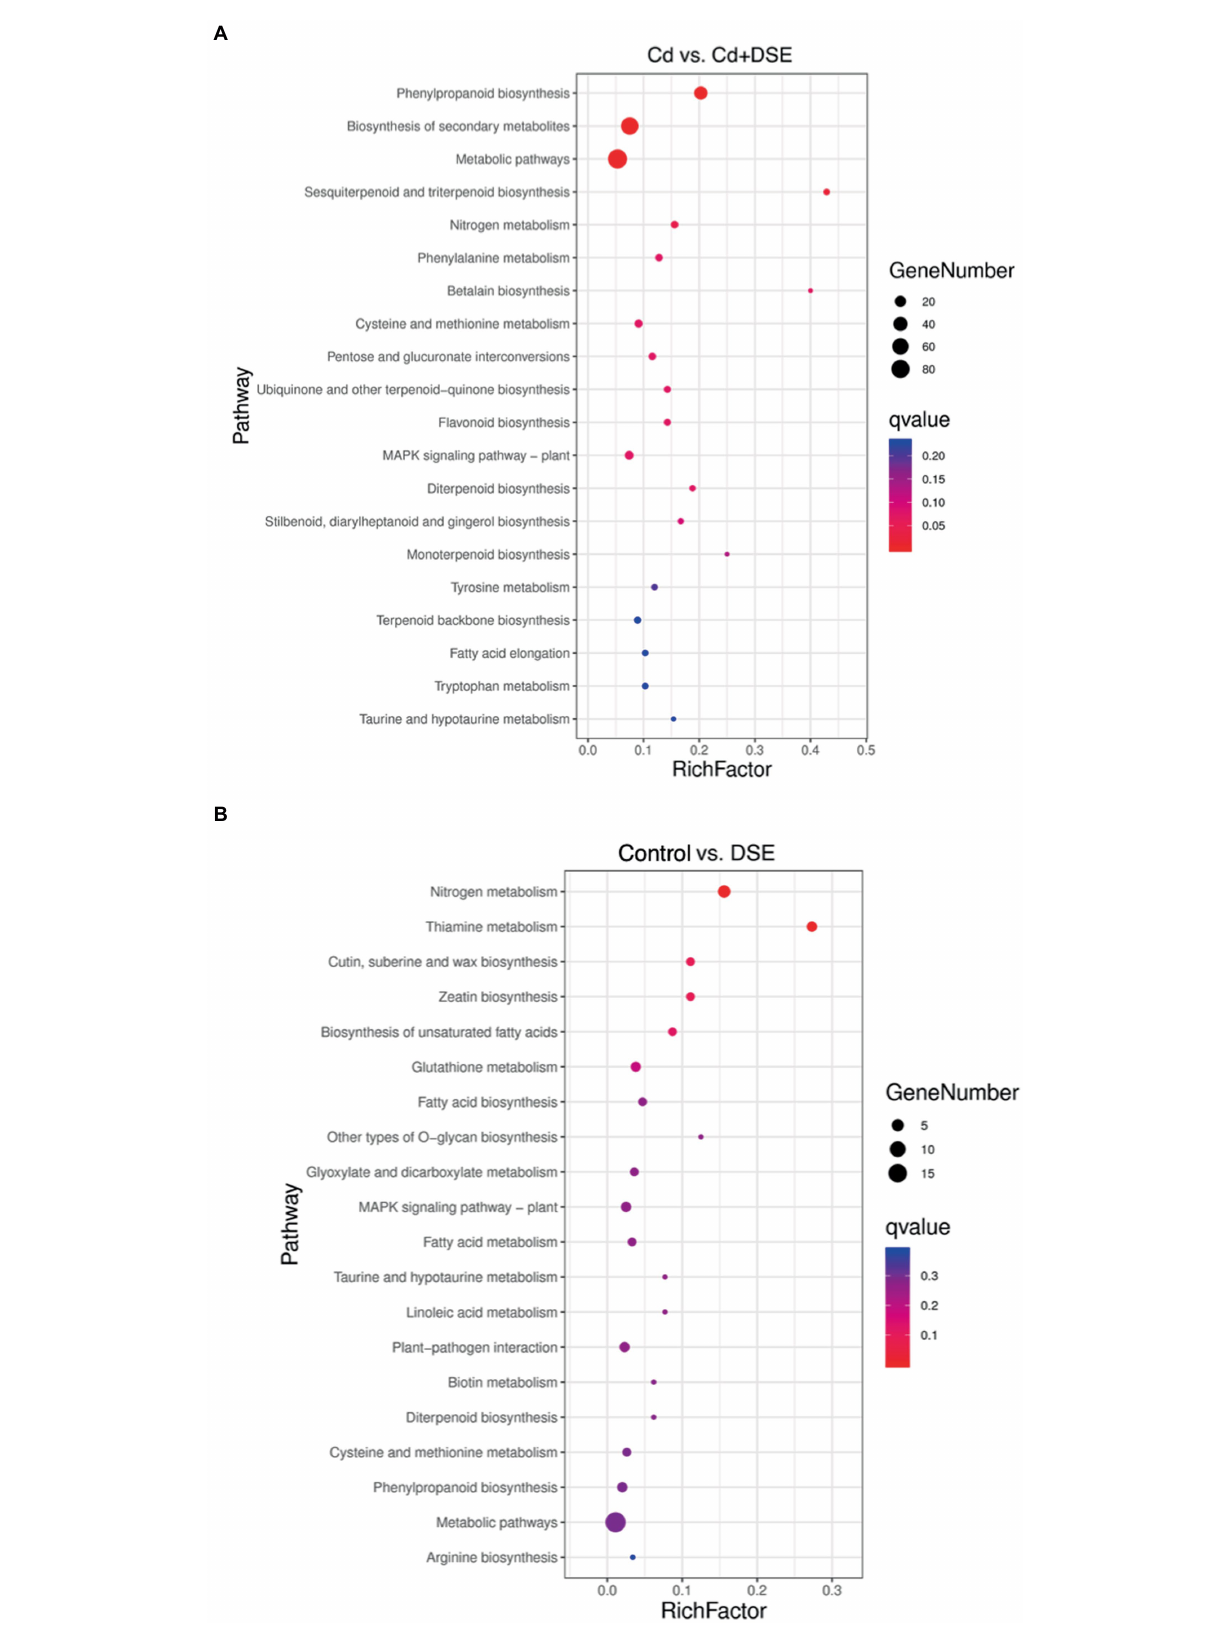
FIGURE 6 Top 20 of KEGG enrichment pathway in (A) Cd vs. Cd + DSE and (B) Control vs. DSE